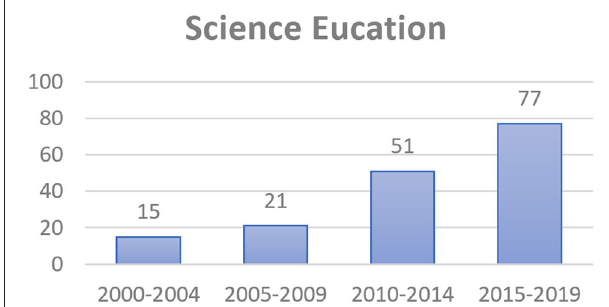
FIGURE 3 | Numbers of the articles published in the science-education journals.